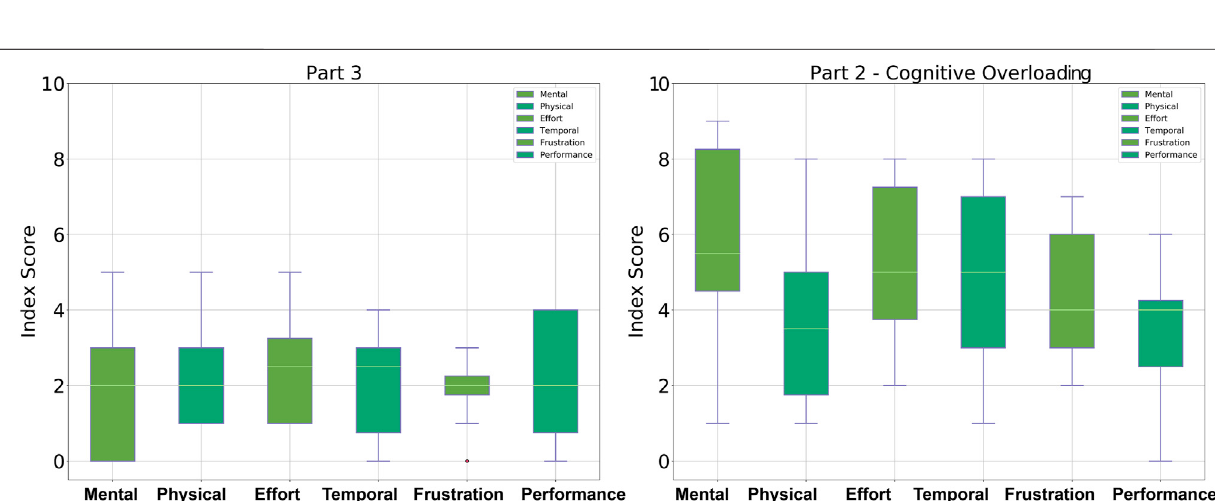
Frontiers in Robotics and AI |